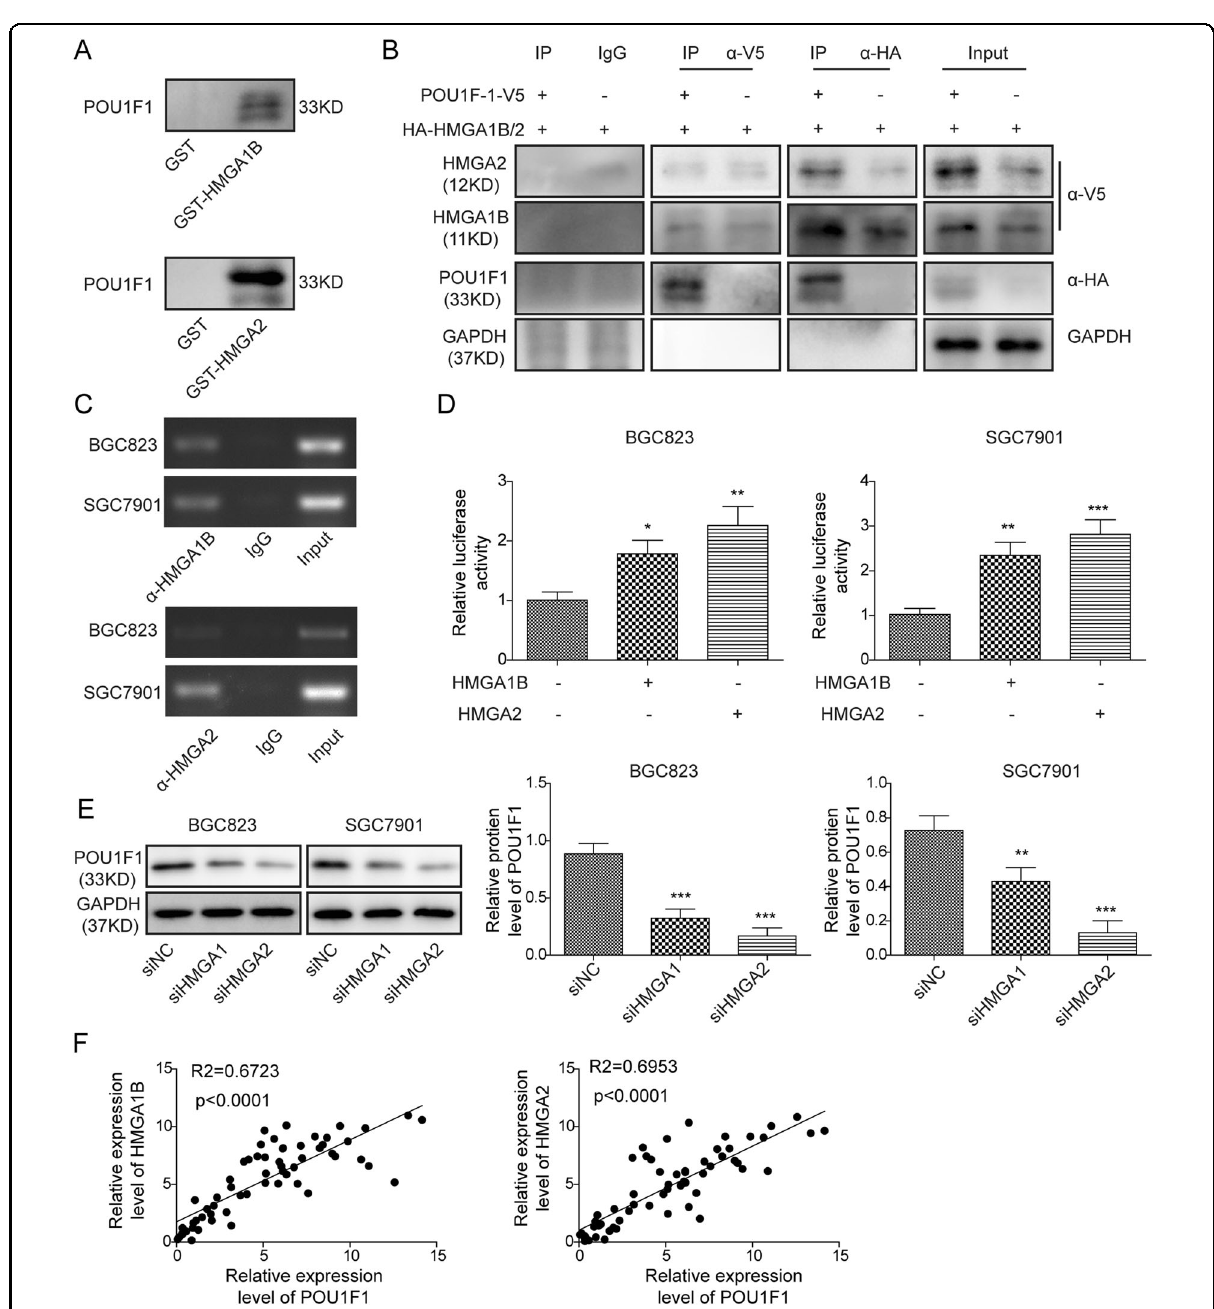
Fig. 4 HMGA1B/2 upregulates POU1F1 transcriptionally. A In vitro interactions between POU1F1 and HMGA1B or HMGA2 were determined by GST pull-down assay. B In vivo interactions between POU1F1 and HMGA1B or HMGA2 were determined by co-IP. Whole-cell lysates served as an input control. C The enrichment of HMGA1 or HMGA2 at POU1F1 promoter was assessed by ChIP assay. Normal IgG served as a negative control. The non-immunoprecipitated chromatin served as an input control. D POU1F1 promoter region containing sequence between nt − 1321 and + 15 was cloned into pGL-3 Basic vector. Luciferase activity was determined by dual luciferase reporter assay. Renilla luciferase activity served as an internal control. E The protein level of POU1F1 was determined by western blot. GAPDH served as a loading control. F The correlations between POU1F1 and HMGA1B or HMGA2 in GC were determined by Pearson correlation analysis. Data were expressed as the mean ± SD of n = 3 experiments. * P < 0.05, ** P < 0.01, *** P <